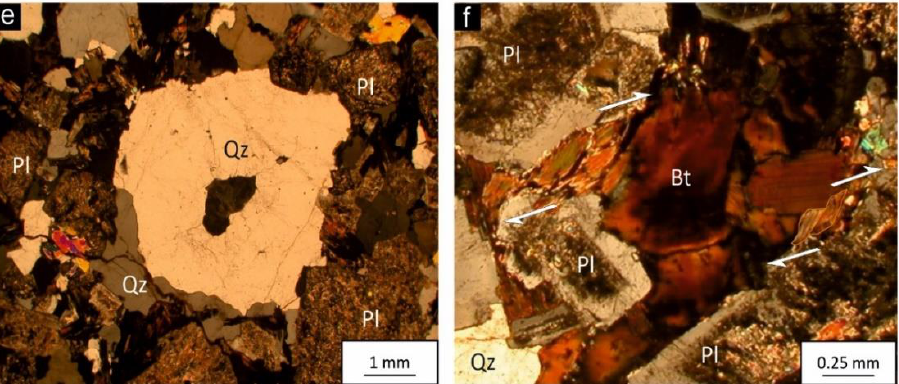
Figure 5. Deformation microstructures from submagmatic to solid-state domain in biotite ± amphibole granodiorites (BAG). ( a ) Large anhedral quartz crystal characterized by chessboard extinction overprinted by a dominant undulose extinction (NDP24-N 38°27 ’ 07 ’’ , E 16°21 ’ 37 ’’ ); ( b ) submagmatic microfracture (yellow lines) filled by subhedral plagioclase after breaking apart a large quartz crystal (SC28-N 38°32 ’ 03 ’’ , E 16°29 ’ 42 ’’ ); ( c ) extremely lobed edges of both quartz and plagioclase crystals, representing examples of high-temperature recrystallization (NDP17-N 38°26 ’ 09 ’’ , E 16°20 ’ 20 ’’ ); ( d ) quartz and plagioclase crystals with wavy boundaries wrapped by biotite grains (SO3-N 38°25 ’ 01 ’’ , E 16°10 ’ 42 ’’ ); ( e ) core-and-mantle microstructure in a quartz crystal showing dynamic recrystallization at its edges (NDP15-N 38°25 ’ 45 ’’ , E 16°20 ’ 27 ’’ ); ( f ) sub-millimetric biotite mica fish, indicating dextral sense of shearing (NDP18-N 38°26 ’ 42 ’’ , E 16°20 ’ 28 ’’ ).